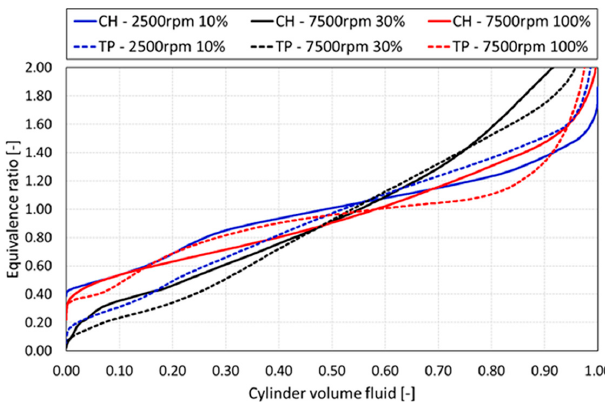
Figure 18. In-cylinder fuel homogenization using PN6 prechamber at 360 °CA: comparison between CH injection (continuous lines) and TP injection (dashed lines).